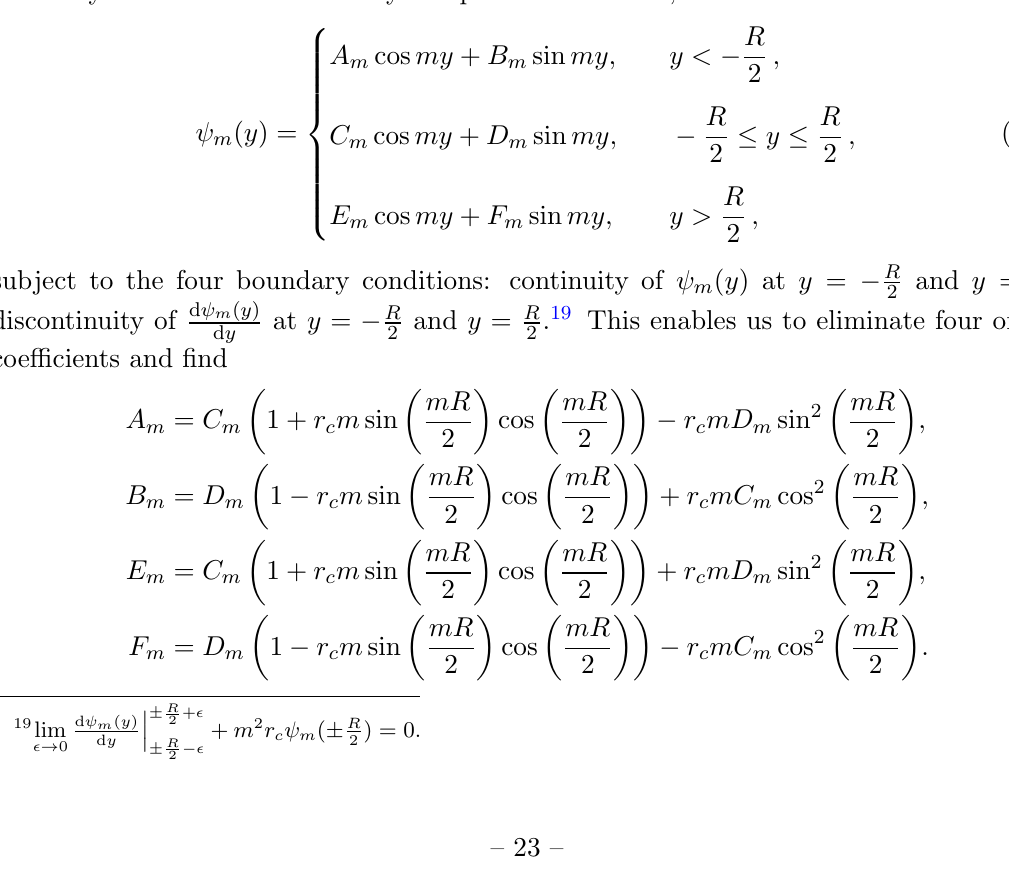
-behavior. Again, r